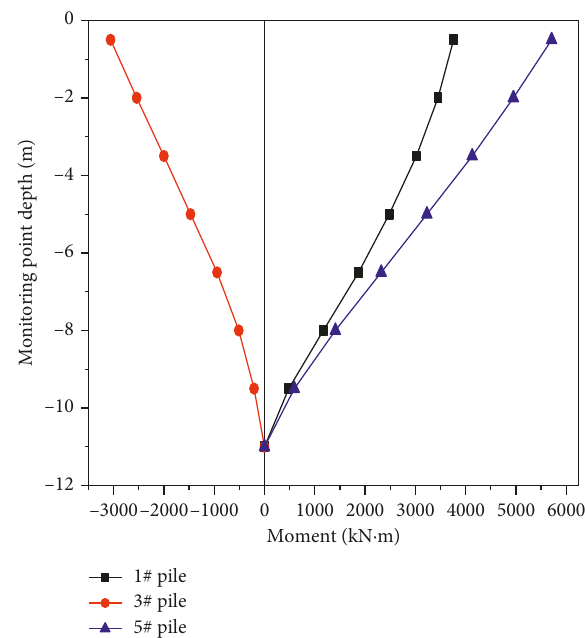
Figure 10: Moment envelope of the